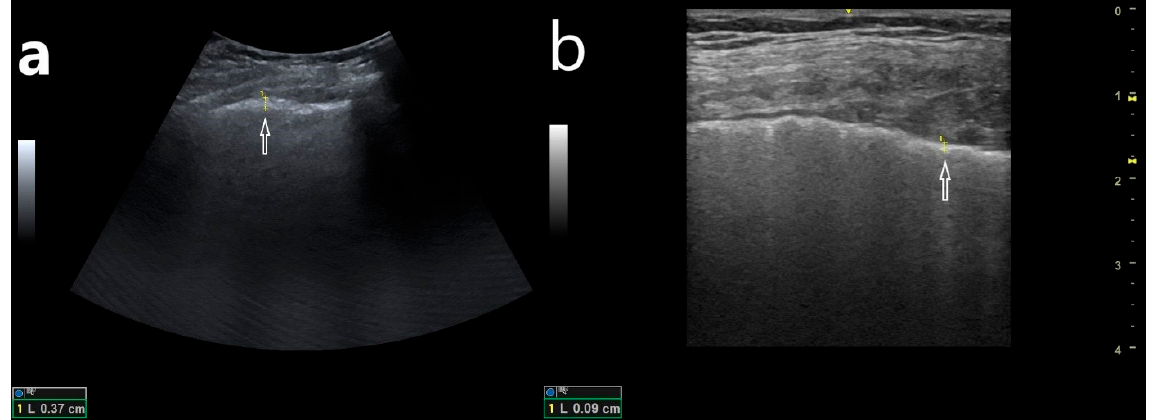
Figure 1. ( a ) B-line artifacts, arising from an apparently thickened pleural line when it was evaluated with a convex transducer (3.1 mm); ( b ) evaluation of the pleural line in the same localization, the pleural line of normal thickness, assessed with a linear transducer (0.09 mm).